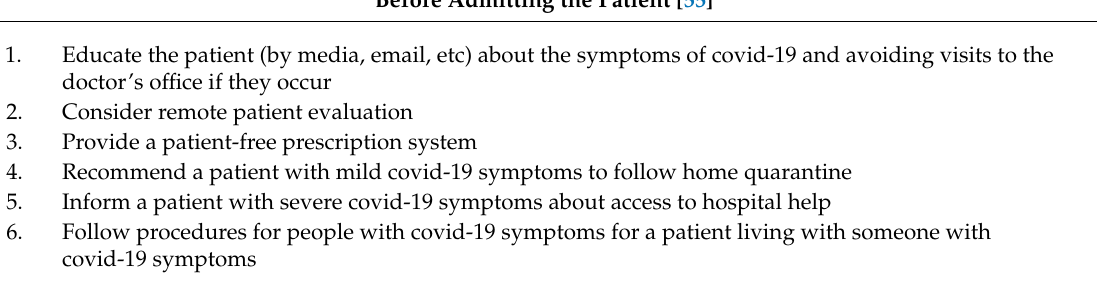
Table 2. Practical recommendations for treatment of dental patients with congenital bleeding disorders during the COVID-19